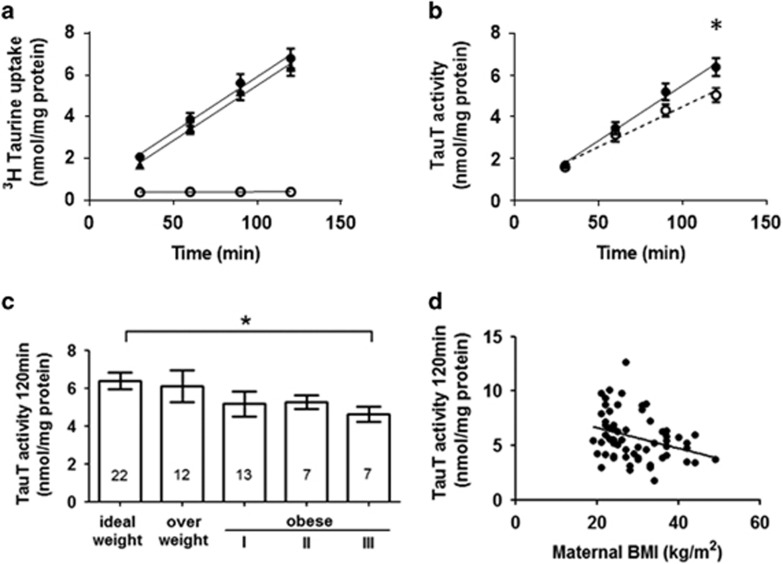
(a) Uptake of 3H-taurine into villous fragments in the presence (●) and absence (○) of Na+ over 30–120 min in the placentas of ideal weight women. The Na+-dependent component of uptake (▴) indicates 3H-taurine uptake owing to TauT activity. There was a linear relationship between TauT activity and time over 30–120 min (least squares linear regression: r2=0.56, P<0.0001). (b) Placental TauT activity was significantly lower in obese women (BMI⩾30 kg m−2; n=27 (○)) compared with women of ideal weight (BMI 18.5–24.9 kg m−2; n=22 (●)) (mean±s.e.; *P<0.03 least squares linear regression). (c) Placental TauT activity (120 min) according to the BMI category (mean±s.e.; *P<0.05; Kruskall–Wallis with Dunn's multiple comparison post hoc test). (d) Placental TauT activity (120 min) was inversely related to maternal BMI (least squares linear regression: r2=0.098; P<0.014 n=61).